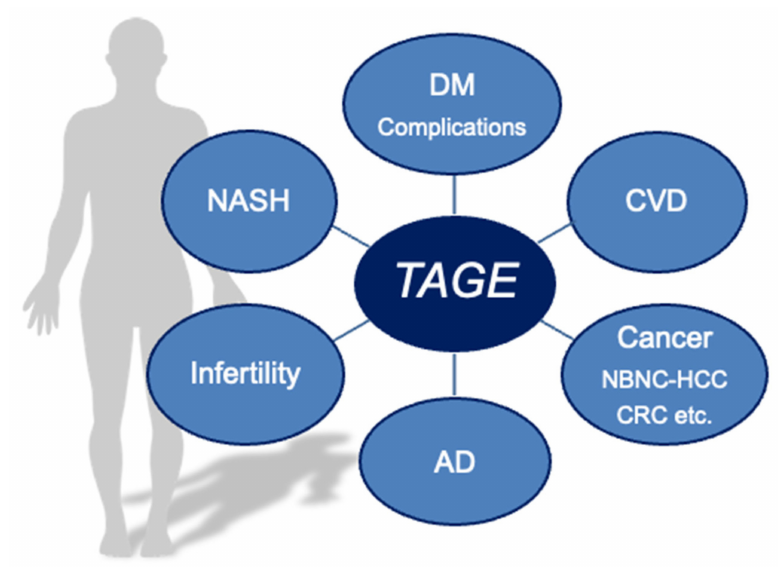
Figure 1. TAGE as a new target for human health. AD: Alzheimer’s disease; CRC: colorectal cancer; CVD: cardiovascular disease; DM: diabetes mellitus; NASH: non-alcoholic steatohepatitis; NBNC-HCC: non-B or non-C (NBNC)-hepatocellular carcinoma; TAGE: toxic advanced glycation